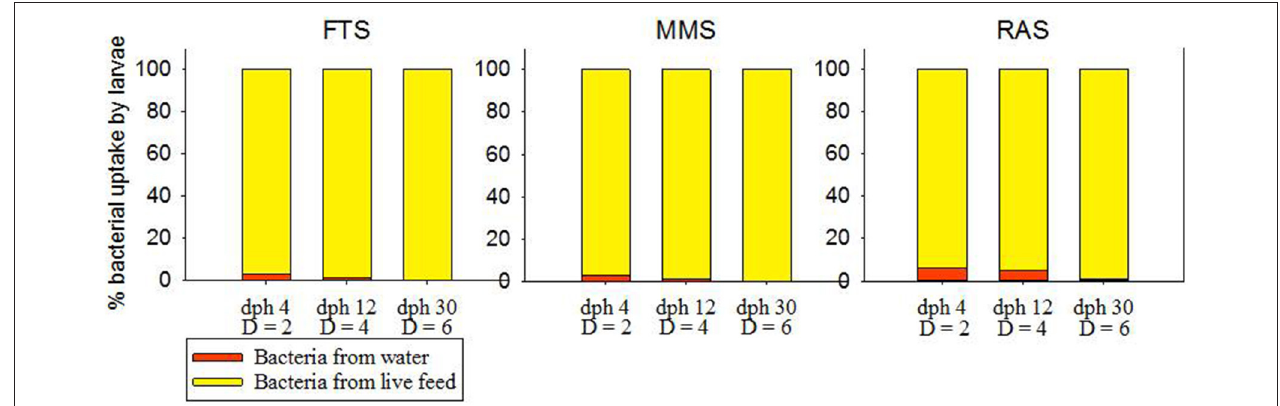
FIGURE 4 | Fraction of the ingested bacteria per larva per day coming from the water and the live food, respectively, at different days post hatch (dph) characterized by different tank dilution rates (D, tank volumes exchanged d − 1